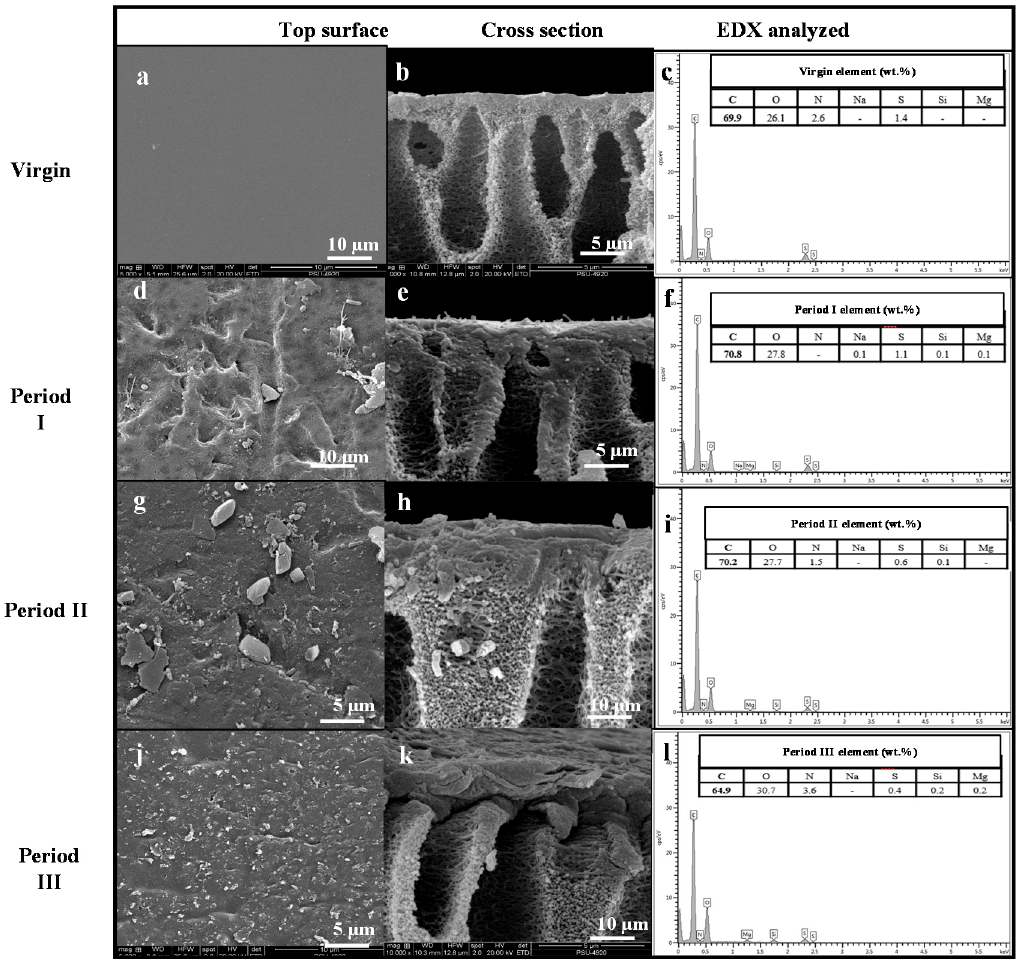
Figure 6. FESEM of the virgin membrane ( a ): top surface, ( b ): cross section, ( c ): EDX element), fouled membrane in period I ( d ): top surface, ( e ): cross section, ( f ): EDX element), fouled membrane in period II ( g ): top surface, ( h ): cross section, ( i ): EDX element), and fouled membrane in period III ( j ): top surface, ( k ): cross section, ( l ): EDX element).